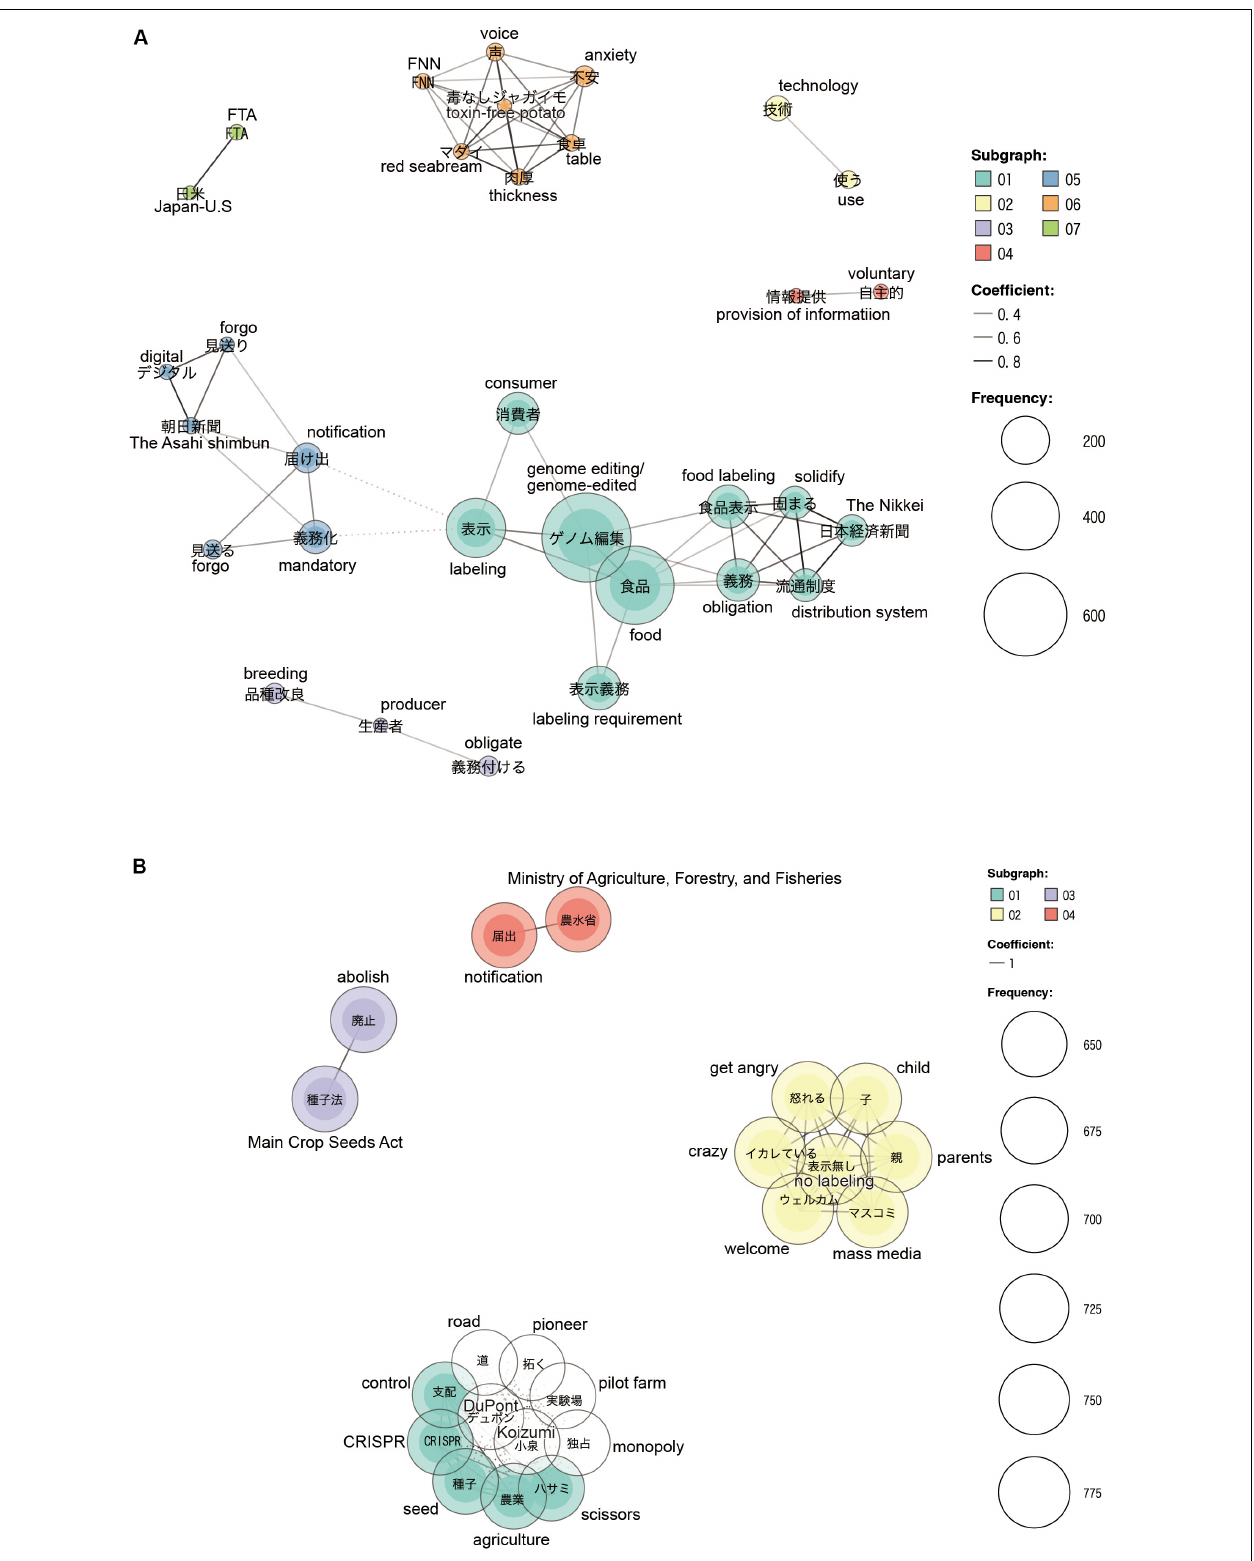
Frontiers in Plant Science |